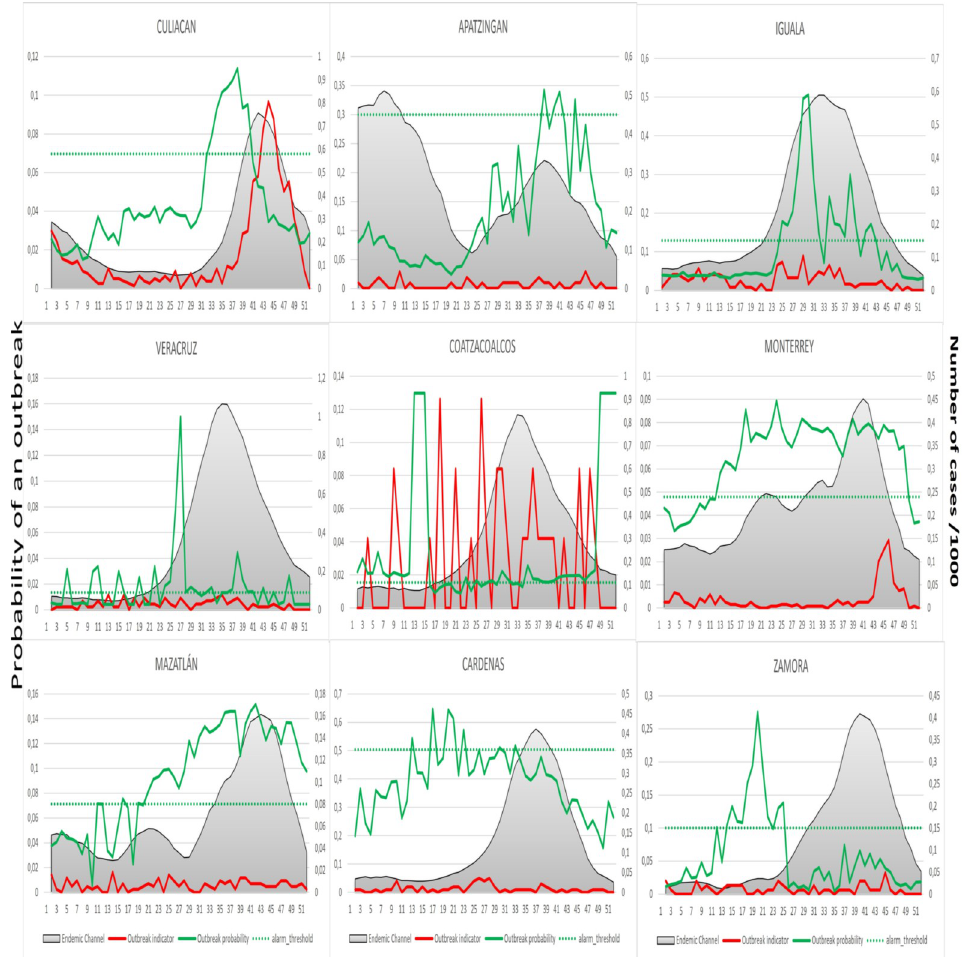
Fig 6. The outbreak predictions as generated by the EWARS for the non-outbreak districts. The endemic channel is presented by the shaded area in grey which includes + z � SD of the moving average; the alarm threshold is represented by the dotted horizontal line; the outbreak probability (“alarm line”) estimated by the EWS is represented by the green line; the weekly dengue incidence rates is represented by the red line.